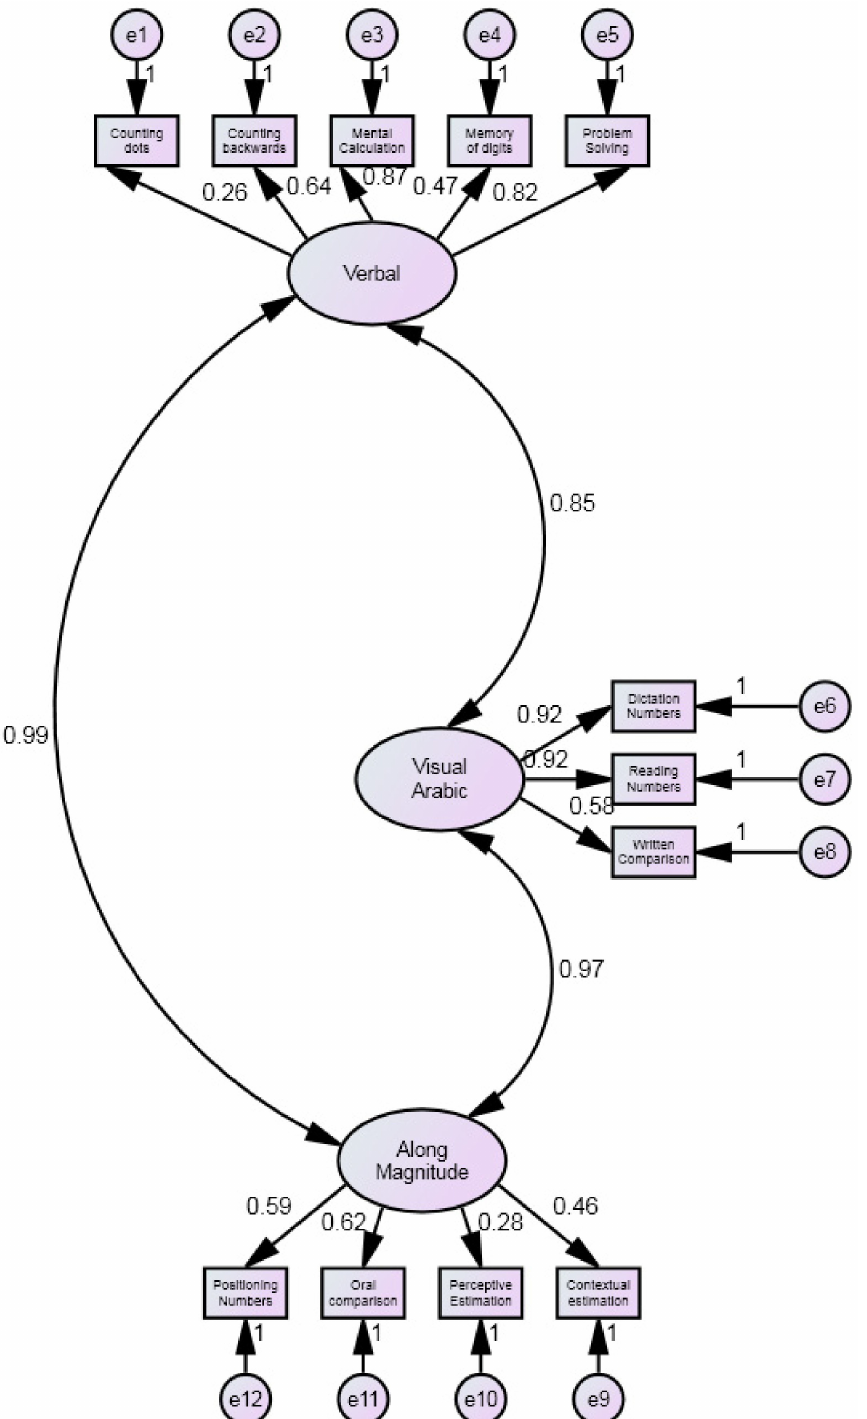
Figure 4. Dehaene’s triple code structure ( Analogical Magnitude , Verbal code and Visual Arabic